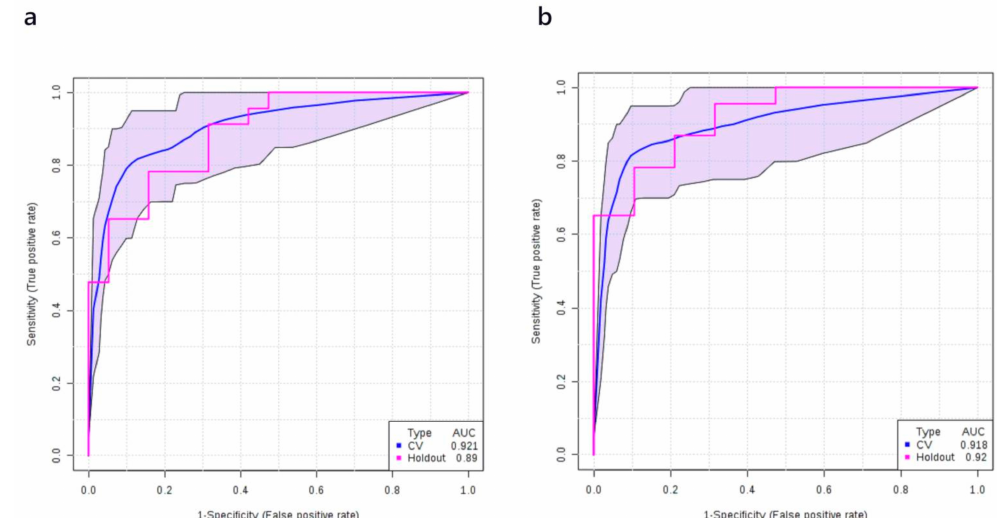
Figure 2. Receiver-operating characteristic (ROC) curve generated by the logistic regression models for diagnosing stage I NSCLC patients. ( a ) ROC curve of the metabolite-only model; ( b ) ROC curve of the metabolites + smoking model. ROC curves and their 95% CI on the discovery set are shown in blue. ROC curves obtained from the validation set are colored in red.